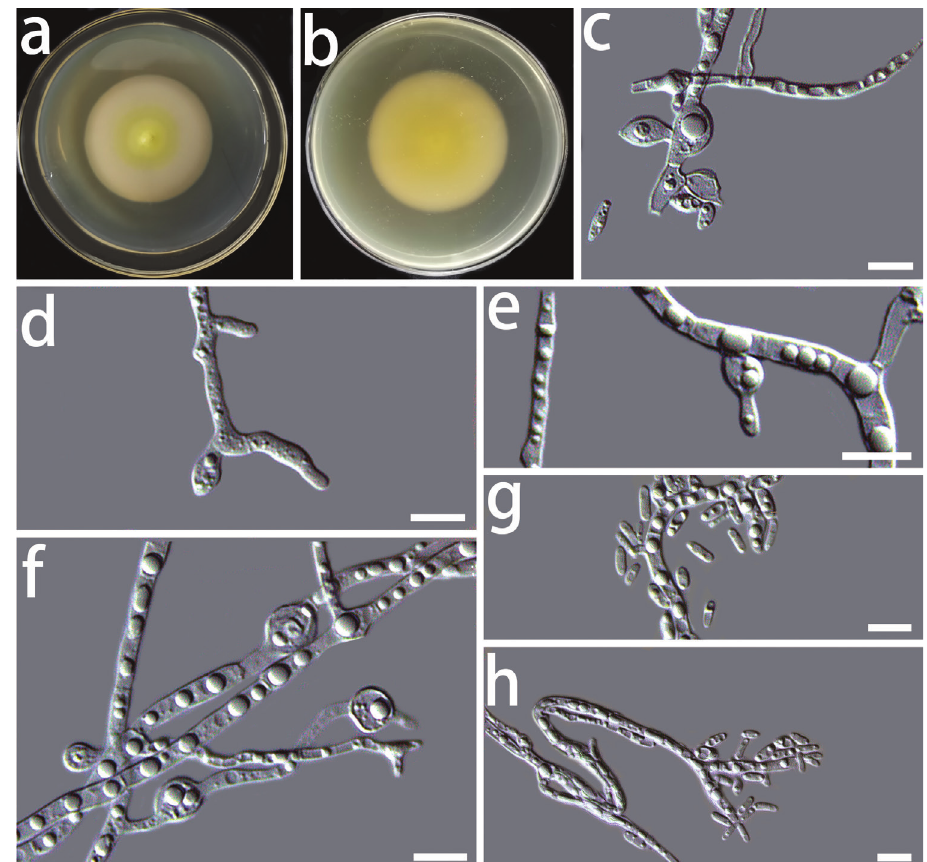
Figure 3. Morphological characters of Coniochaeta sinensis sp. nov. (HMAS 350269) a, b cultures on PDA from the surface and reverse c, d conidiogenous cells e conidiogenous cell that is producing conidia f chlamydospores g, h conidia. Scale bars: 10 shapes and sizes of chlamydospores. When compared to C. mongoliae sp. nov., C. sinensis sp. nov. has smaller conidiogenous cells and conidia. The conidia of C. sinensis sp. nov. are significantly smaller than those of C. fasciculata (Beyma 1939). Aside from that, the chlamydospores of C. sinensis sp. nov. are longer than those of C. mongoliae sp. nov.